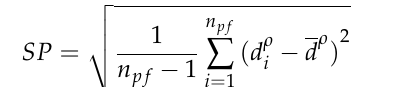
Table 6. Metric of spacing for different